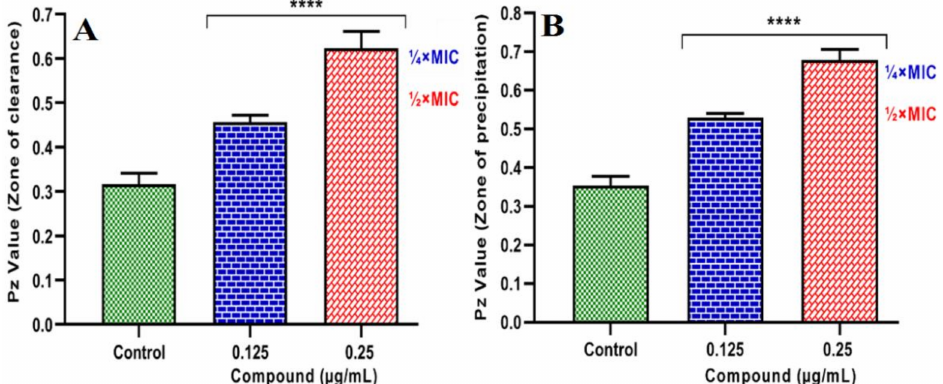
Figure 15. Effect of bimetallic Ag-Cu NPs on proteinase ( A ) and phospholipase ( B ) production by C. albicans : The yeast cells were exposed to 1 / 4 × MIC and 1 / 2 × MIC values of bimetallic Ag-Cu NPs. The untreated cells are represented as control. A high Pz value represents low enzyme activity. Data are presented from three independent experiments using means ± S.D. **** p value <